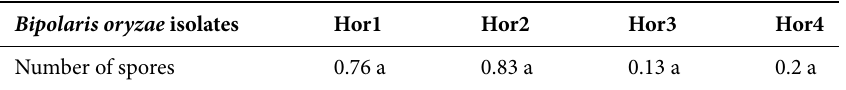
Table 4 Sporulation of Bipolaris oryzae on Typha latifolia leaves aer inoculation with mycelial discs (×10 5 spores/cm 2